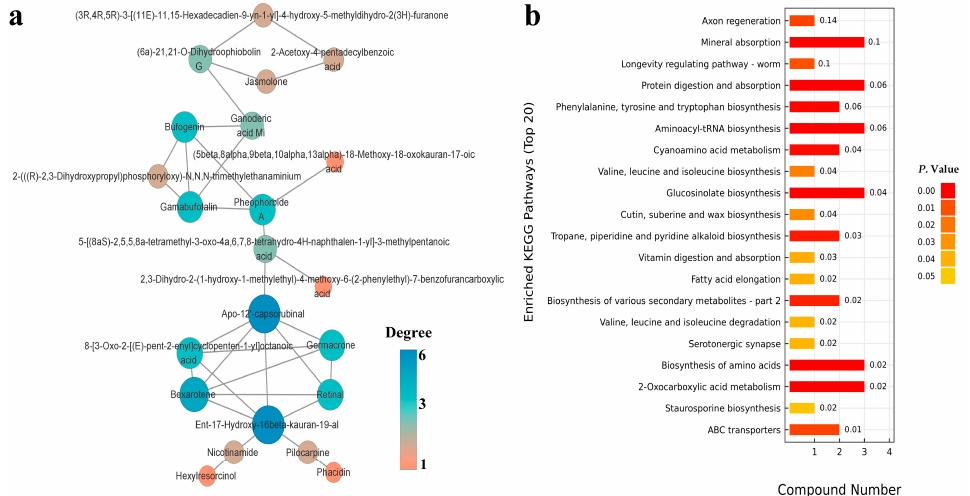
Figure 6. Differential metabolite correlation network in positive mode ( a ) and Kyoto Encyclopedia of Genes and Genomes (KEGG) pathway enrichment ( b ). The vertical axis in the bar graph represents each KEGG metabolic pathway, and the horizontal axis represents the number of differentially expressed metabolites contained in each KEGG metabolic pathway. The color represents the p -value of the enrichment analysis, and the darker the color is, the smaller the p -value and the more significant the degree of enrichment. The number on the column represents the enrichment factor, and the enrichment factor represents the ratio of the number of differential metabolites in the pathway to the number of annotated metabolites in the pathway.